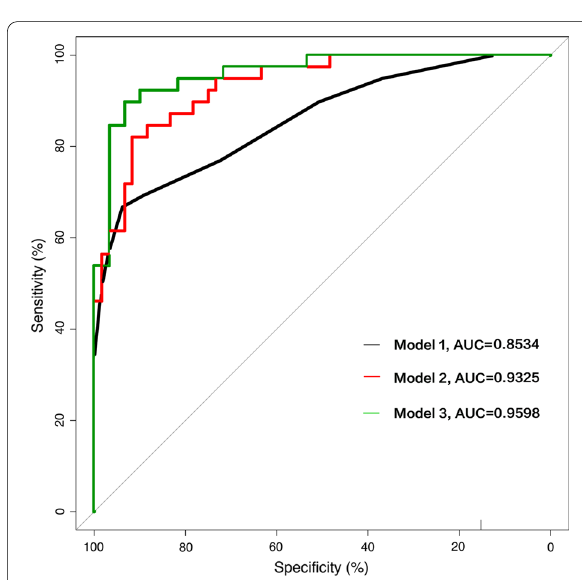
Fig. 2 The ROC curves of the three models. Model 1: single NIHSS score, AUC 0.8534; Model 2, NIHSS cardiac = + parameters (CK‑MB, EF), AUC 0.9325; Model 3, = NIHSS CK‑MB EF age AST NLR albumin, AUC 0.9598. We + + + + + + = compare the three models: model 1 vs model 2, z 2.85, p 0.004; = − = model 2 vs model 3, z 1.58, p = − =